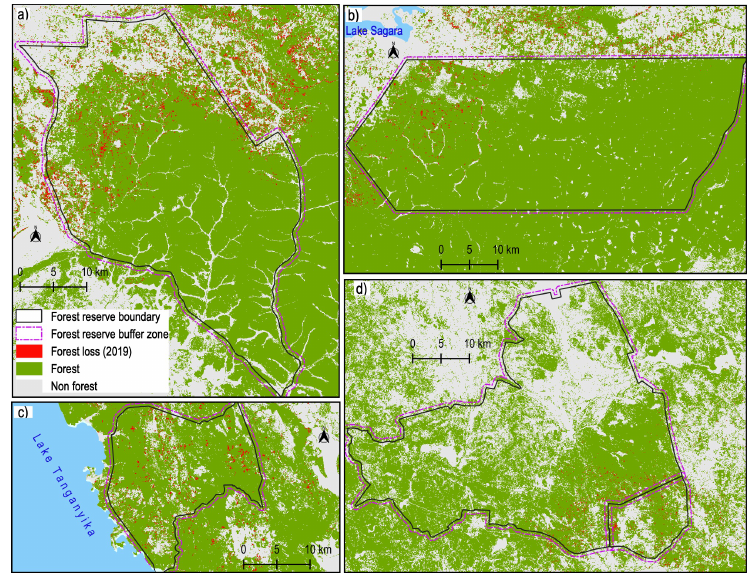
Figure 10. A sample of forest cover loss in protected areas on the western part of the country with a buffer of 500 m: ( a ) Msaginia forest reserve, ( b ) Ugalla North forest reserve, ( c ) Loasi river forest reserve, and ( d ) Lugufu and Mkuti forest reserve.